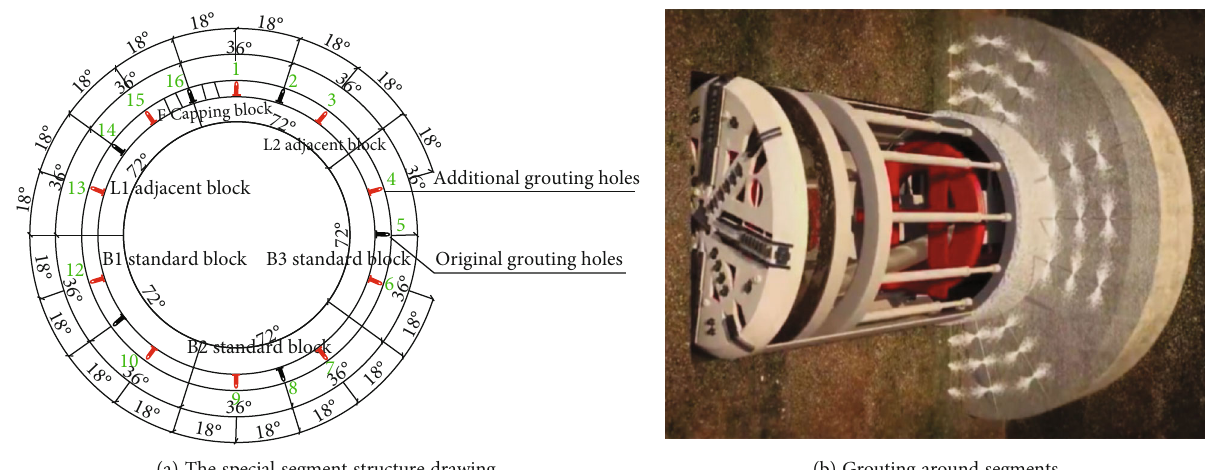
Figure 8: The special segment after the